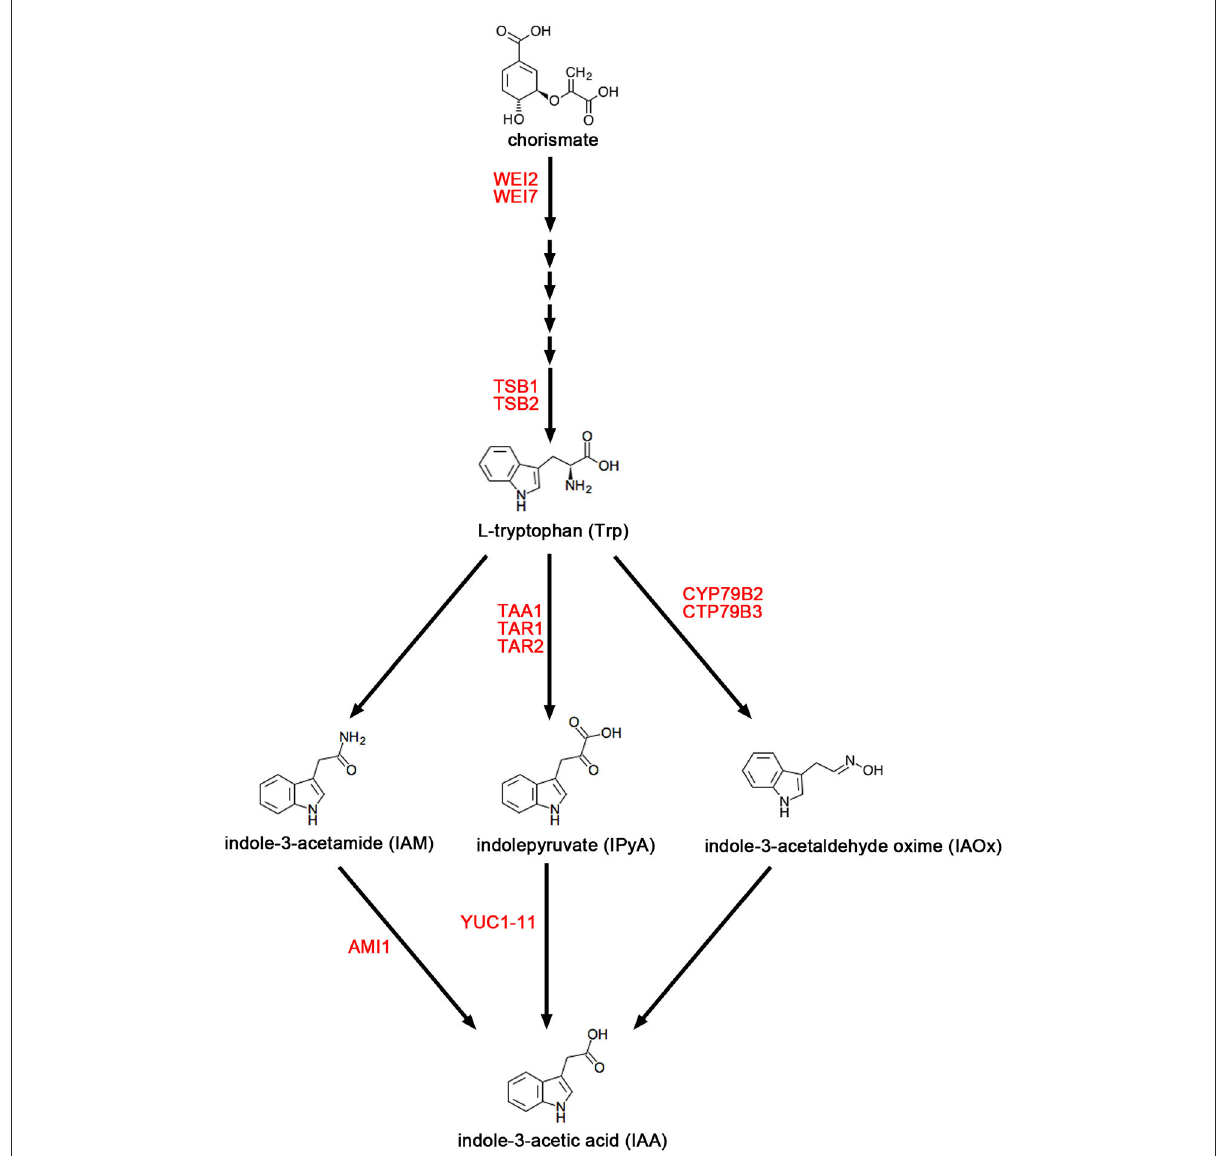
FIGURE1 The main pathways of auxin biosynthesis. The figure shows three parallel Trp-dependent (TD) IAA biosynthesis pathways in Arabidopsis , namely the indole-3-acetamide (IAM) pathway, and the indole-3-pyruvic acid (IPyA) pathway, and the indole-3-acetaldoxime (IAOx) pathway. Enzymes mentioned in this review are in red